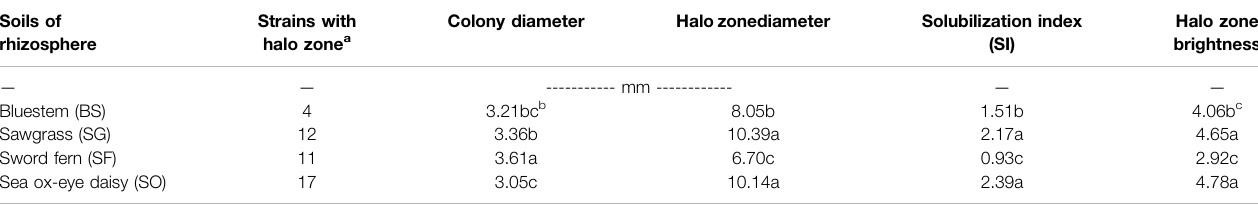
TABLE 2| Comparison ofcolonydiameter,halozonediameter,solubilization index(SI),and halozonebrightnessforphosphorussolubilizingabilitiesofrhizospherebacteria on NBRIP plates. Soils of Strains with rhizosphere halo zone a